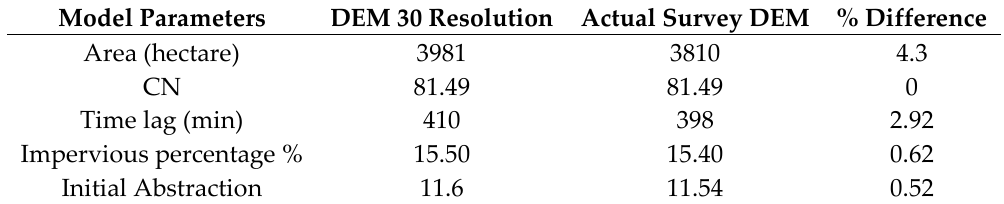
Figure 7. Data used for hydraulic modeling, ( a ) Comparison of drainage patterns from 30 m digital elevation model (DEM) and the actual survey data; ( b ) Land use map for the City of Buraydah. Table 2. Parameters of model obtained by using two sources (30 m DEM and actual survey data) for Al Khaleej.